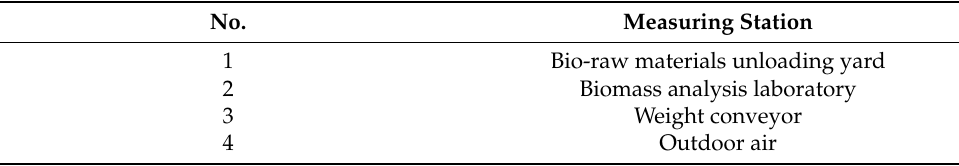
Table 2. Sampling points in the power